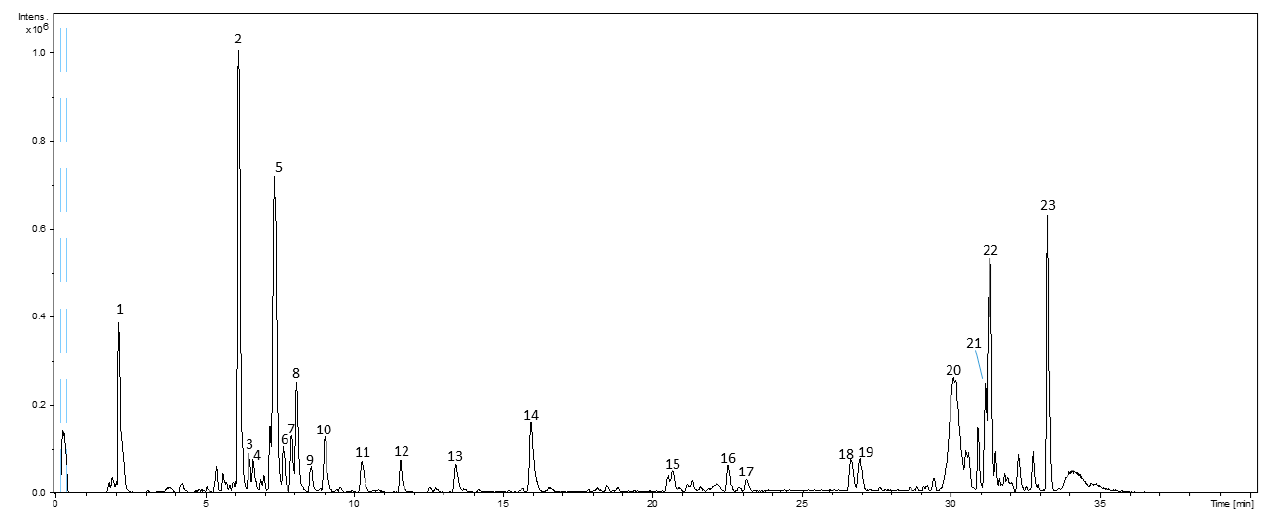
Figure 1. Base peak chromatogram (BPC) of representative pressurized liquid extraction (PLE) extracts of Cynara scolymus L. by-products.